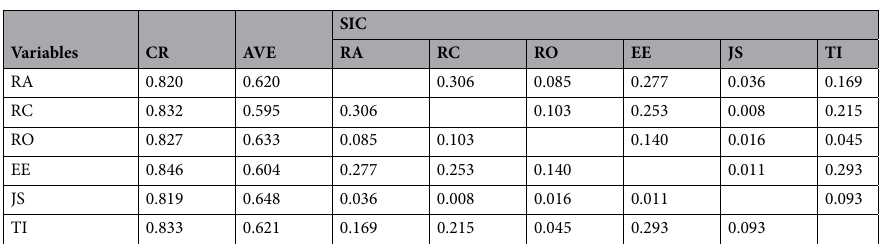
Table 4. Result of validity analysis. Source: Made by the authors. RA Role ambiguity, RC Role conflict, RO Role overload, EE Emotional exhaustion, JS Job satisfaction, TI Turnover intention, CR composite reliability, AVE Average variance extracted, SIC squared inner construct correlation